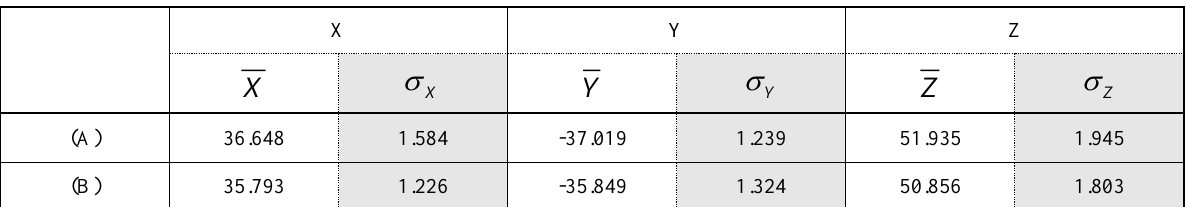
(A)… Three dimensional measurement using all image relations (B)… Three dimensional measurement using only chosen image relations 𝑋̅ , 𝑌,̅ 𝑍̅ = The average of each direction of the characteristic point three dimensions coordinate value 𝜎 𝑥 , 𝜎 𝑌, 𝜎 𝑍 = Standard deviation of the measurement error of each direction of the characteristic point three dimensions Table 2. A result of accuracy comparison of three-dimensional coordinate of feature point